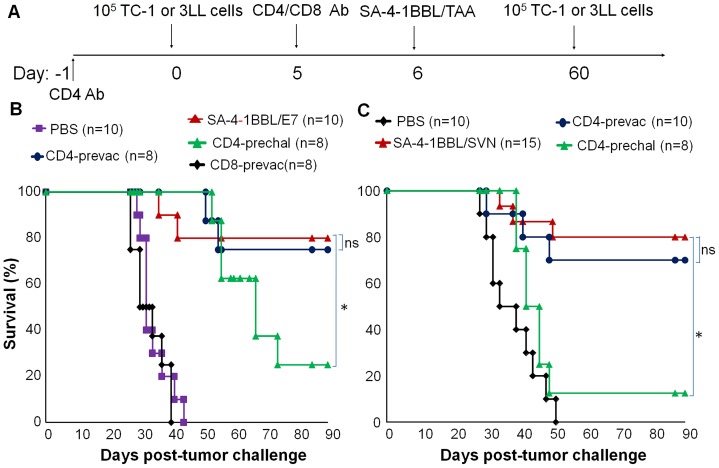
CD4+ T cells play a critical role in the SA-4-1BBL/TAAs-induced therapeutic primary responses against tumors.(A) Schematic depiction of the experimental procedure. (B) Assessing the role of CD4+ and CD8+ T cells in the SA-4-1BBL/E7 vaccine induced therapeutic immunity against TC-1 tumor. C57BL/6 mice were treated i.p. with depleting doses of Abs against CD4 (500 μg/mouse) or CD8 (500 μg/mouse) either one day before vaccination (CD4 or CD8-prevac) with an optimized formulation of SA-4-1BBL/E7 (25/50 µg) administered on day 6 post-tumor challenge or one day before tumor challenge (CD4-prechal) Controls included mice without T cell depletion vaccinated with SA-4-1BBL/E7 or PBS. (C) Assessing the role of CD4+ T cells in the SA-4-1BBL/SVN vaccine induced therapeutic immunity against 3LL tumor. C57BL/6 mice were inoculated with 1×105 3LL tumor cells s.c. and vaccinated with SA-4-1BBL/SVN (25/50 µg) on day 6 post-tumor challenge. One group of mice received the depleting dose of anti-CD4 Ab one day before tumor challenge (CD4-prechal) while another group received the Ab one day before vaccination (CD4-prevacc) *P<0.01; ns, not significant. Some of the mice in SA-4-1BBL/SVN and CD4-prevac groups have recently been published (ref. 31) and pooled with more mice and graphed for comparison purposes.